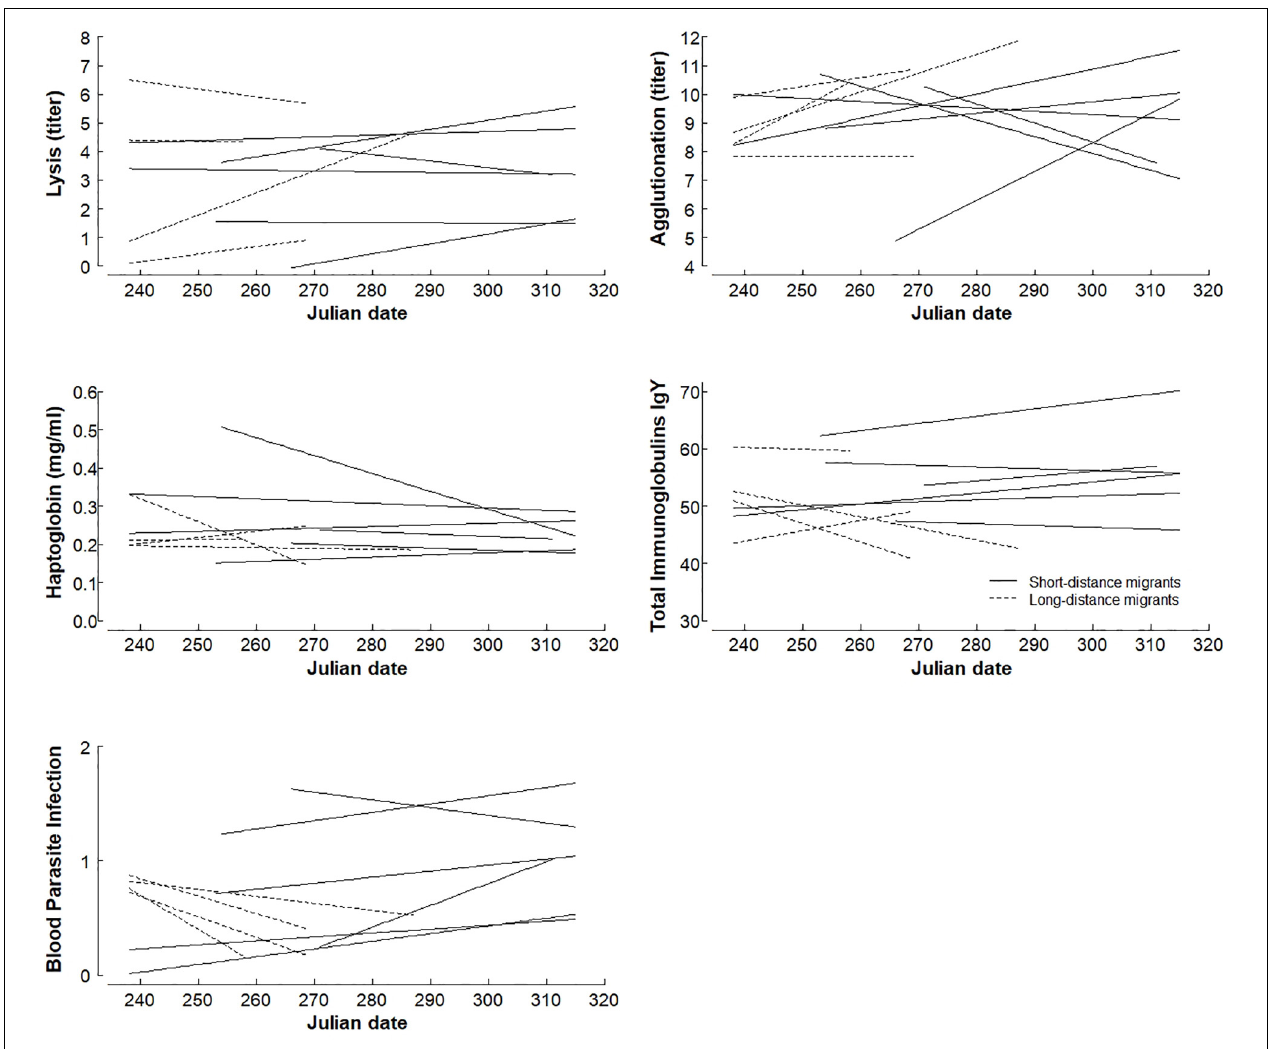
FIGURE 1 | Within-seasonal patterns of constitutive immune function and blood parasite infections in 417 individual migrants from 10 species sampled during autumn migration in Falsterbo, Sweden. Each line represents the relationship between Julian date and immune function or blood parasite infection for a single species, with dashed lines representing long-distance migrants (wintering in Africa) and solid lines presentencing short-distance migrants (wintering in Southern and Western Europe). Note that y -axis for agglutination and total immunoglobulins do not start at zero. Figures showing individual data points for each species can be found in the Supplementary Material